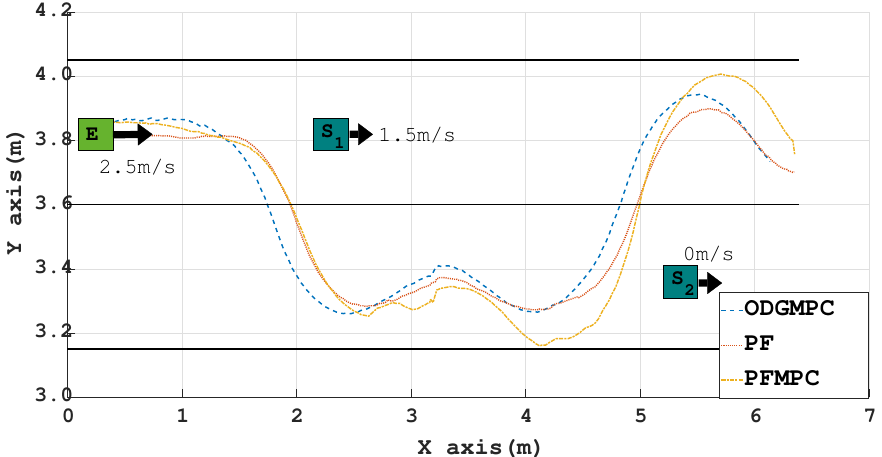
Figure 29. Results of the path from Scenario 3 for one dynamic obstacle and one static obstacle.